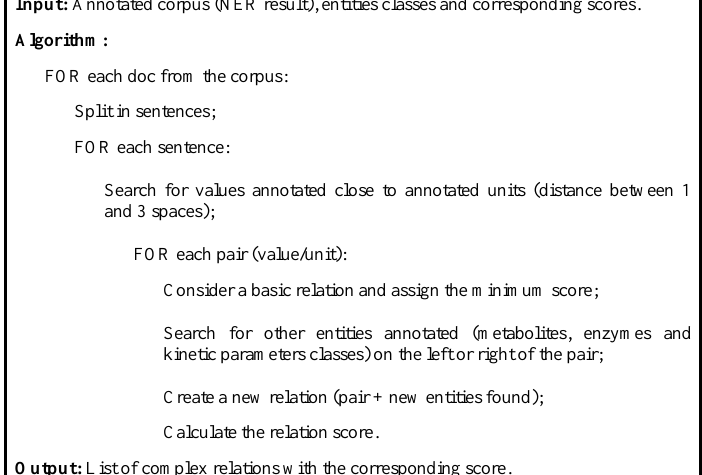
Figure 3: Algorithm for relation extraction in KineticRE.